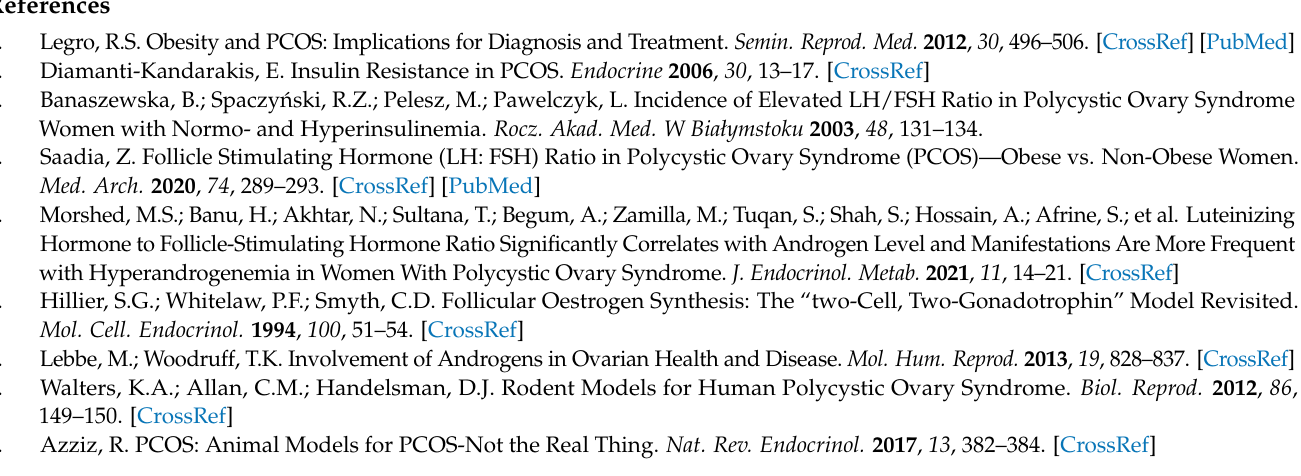
Figure S1: Timing and magnitude of the mid-cycle estradiol peak differs in response to stimulation with different gonadotropin concentrations; Figure S2: Comparison of cumulative follicular and cumulative luteal phase hormone production; Figure S3. Luteal-to-follicular progesterone ratio is decreased in G30